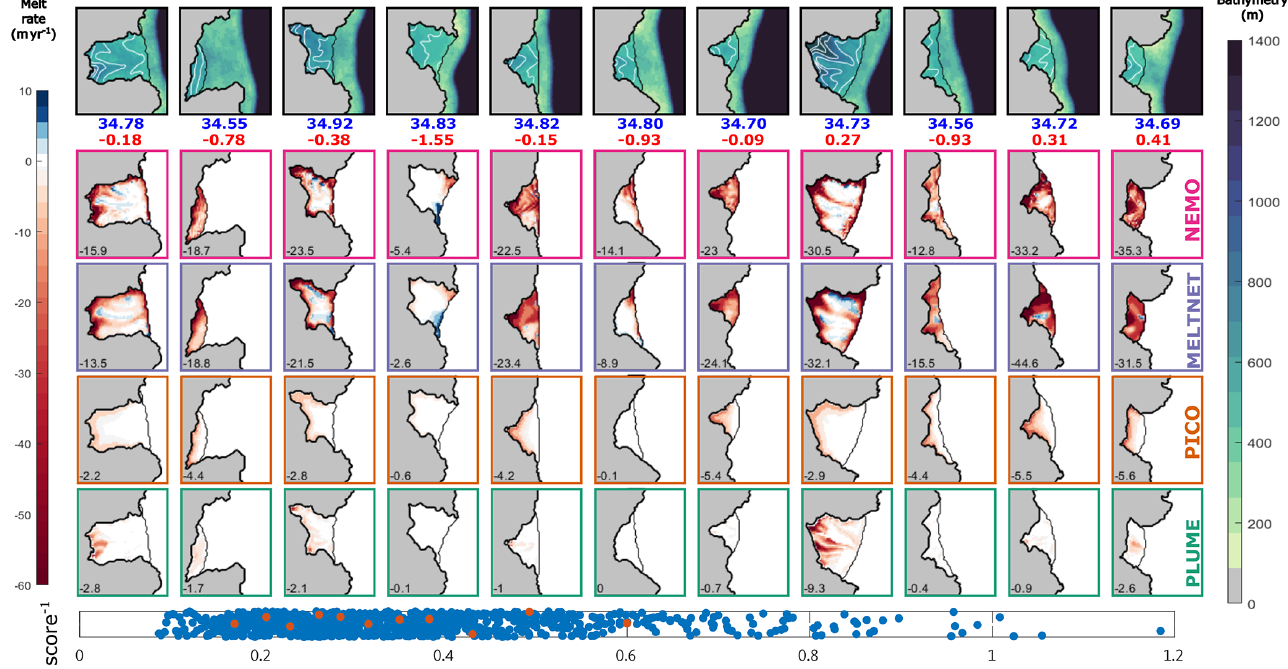
Figure 3. Input geometry (row 1) for a sample of synthetic ice shelves and the resulting melt rates (myr − 1 ) as calculated by NEMO (row 2), MELTNET (row 3), PICO (row 4) and PLUME (row 5). Experiments were selected by sampling evenly from the distribution of MELTNET scores. Scores, calculated as a combination of NRMSE and correlation coefficient, are shown in blue in row 6, and the sampled experiments are highlighted in red. Only geometries from the test set are included in this figure. Background colour map for the geometries shows ocean bathymetry (scale on the right-hand side), and white lines show ice-shelf draft, contoured from 200 to 800m at 100m intervals. Melt rate results all use the same colour map, with red and blue indicating melting and refreezing, respectively. Note the colour map gradient is not linear but is greatest around zero, to make it easier to distinguish the magnitude of melting/refreezing over the bulk of the ice shelves. Numbers in red and blue at the top of each melt rate column show the area-averaged sub-ice-shelf temperature and salinity, respectively. Numbers in the bottom left corner of each melt rate panel show the averaged melt rate as calculated by each model. Both the PICO and PLUME models show results using optimised parameters (Table